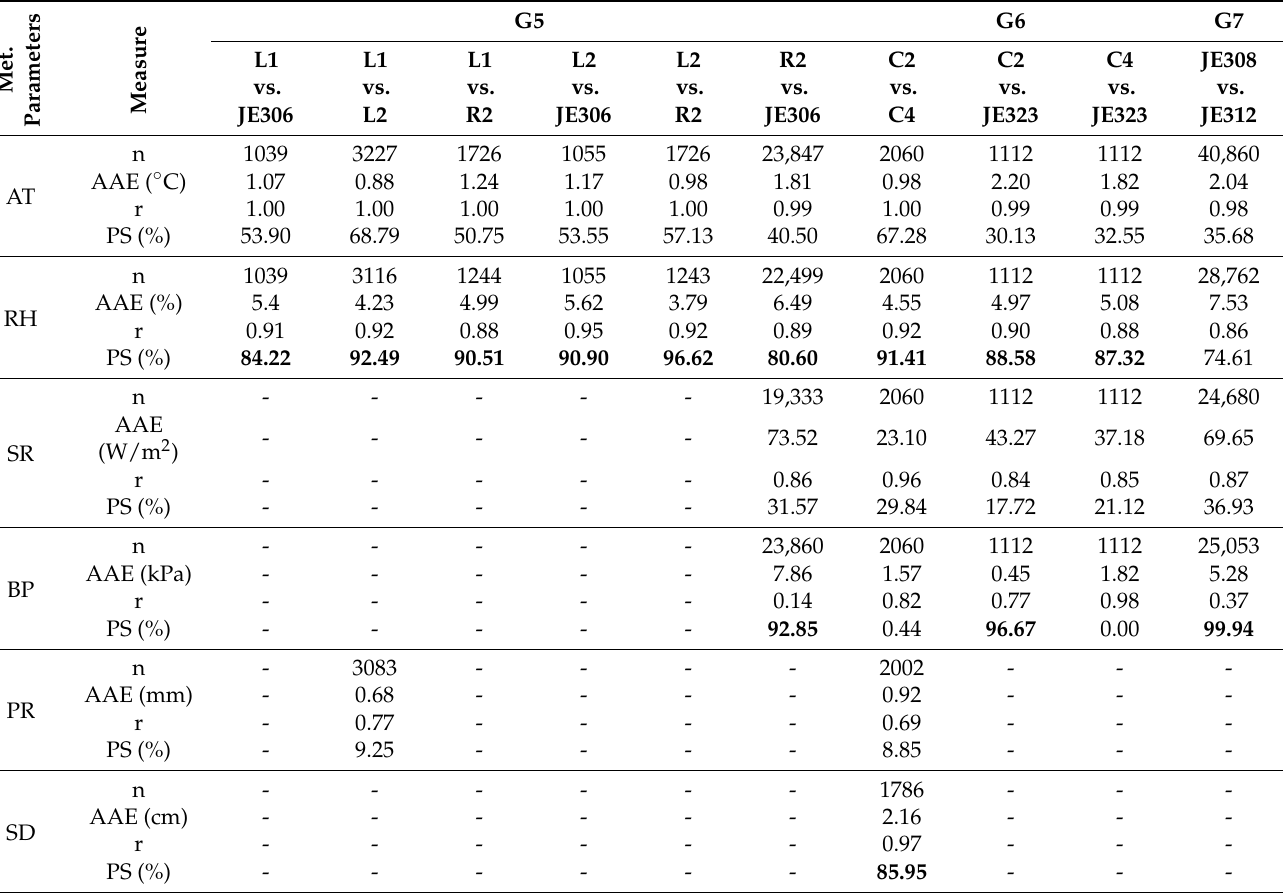
Table 4. The analysis of similarity and relations among the meteorological parameters for G5 and G6 groups, measured at 2 m height. The sign ‘-’ meant the measurements were unavailable for comparison, and highlighted bold values meant strong PS with ≥